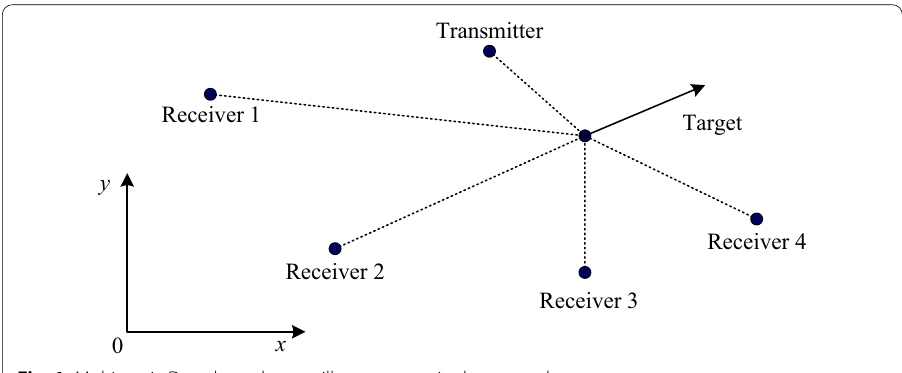
Fig. 1 Multi-static Doppler-only surveillance system in the x − y